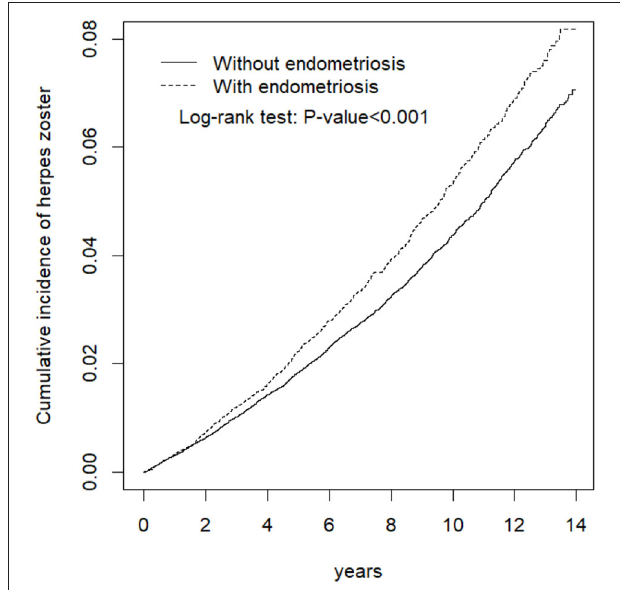
FIGURE 2 | Cumulative incidence comparison of herpes zoster for patients with (dashed line) or without (solid line)